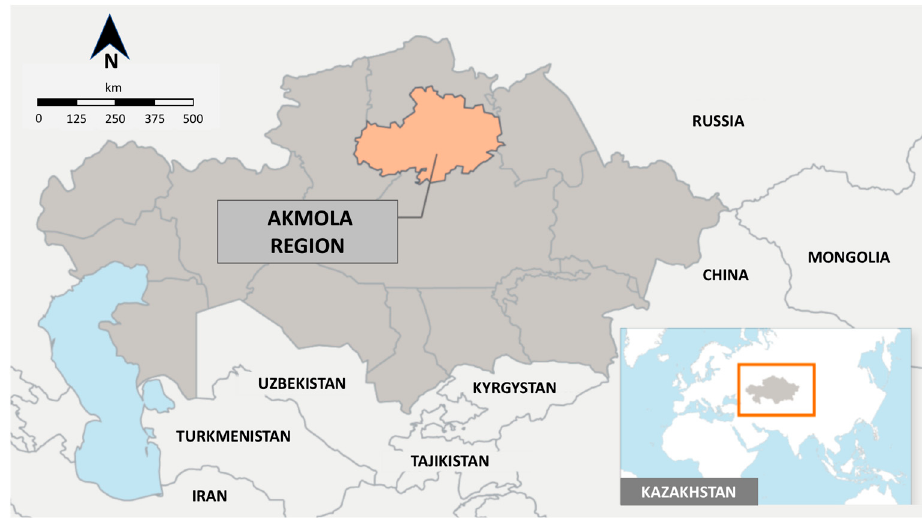
Figure 1. Location of the Akmola Region inside the Republic of Kazakhstan.